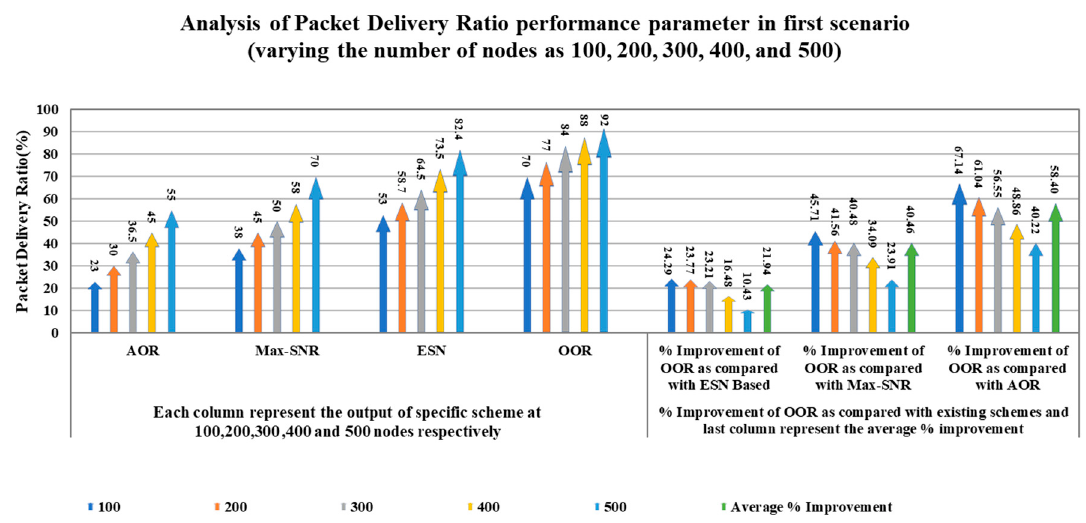
Figure 7. Detailed performance reflection of OOR with packet delivery ratio parameter.